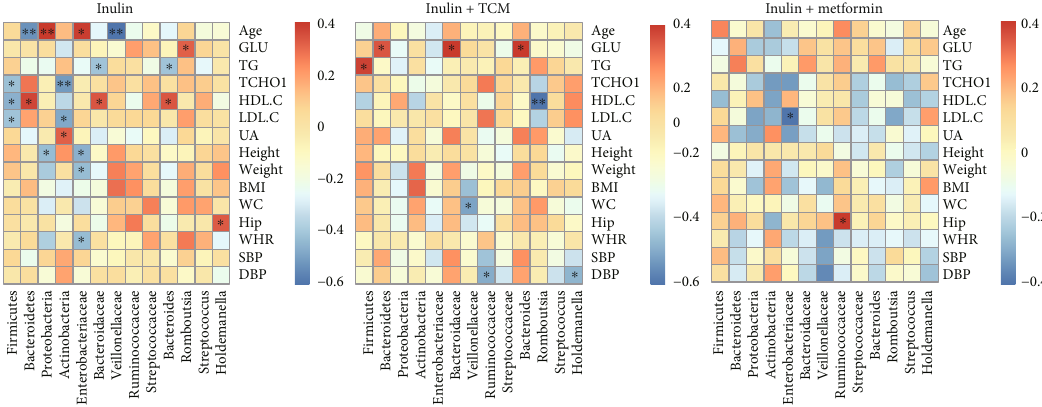
Figure 4: Heatmaps of correlations between species abundance (columns) and clinical parameters (rows) in patients with metabolic syndrome. Red and blue shades: positive and negative correlations, respectively. BMI: body mass index; DBP: diastolic blood pressure; GLU: glucose; HDL. C: high-density lipoprotein cholesterol; Hip: hip circumference; LDL. C: low-density lipoprotein cholesterol; SBP: systolic blood pressure; TCHO1: total cholesterol; TG: triglyceride; UA: uric acid; WC: waist circumference; WHR: waist to hip ratio (circumference). ∗ Statistically signi fi cant correlations.